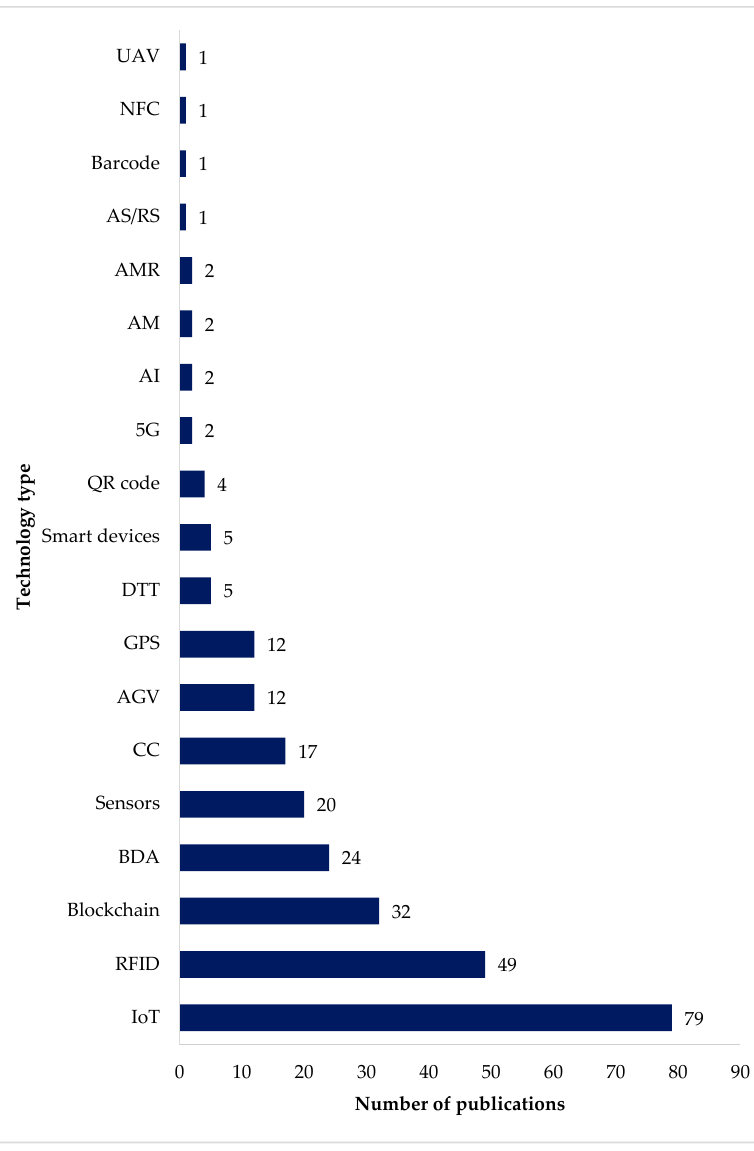
Figure 6. Distribution of the papers reviewed based on type of technology covered. IoT = internet of things; RFID = radio frequency identification; BDA = big data analytics; CC = cloud computing; AGV = autonomous guided vehicles; GPS = global positioning system; DTT = digital twin technology; QR code = quick response code; 5G = fifth-generation technology; AI = artificial intelligence; AM = additive manufacturing; AMR = autonomous mobile robots; AS/RS = automated storage and retrieval systems; NFC = near-field communication; UAV = unmanned autonomous vehicles.